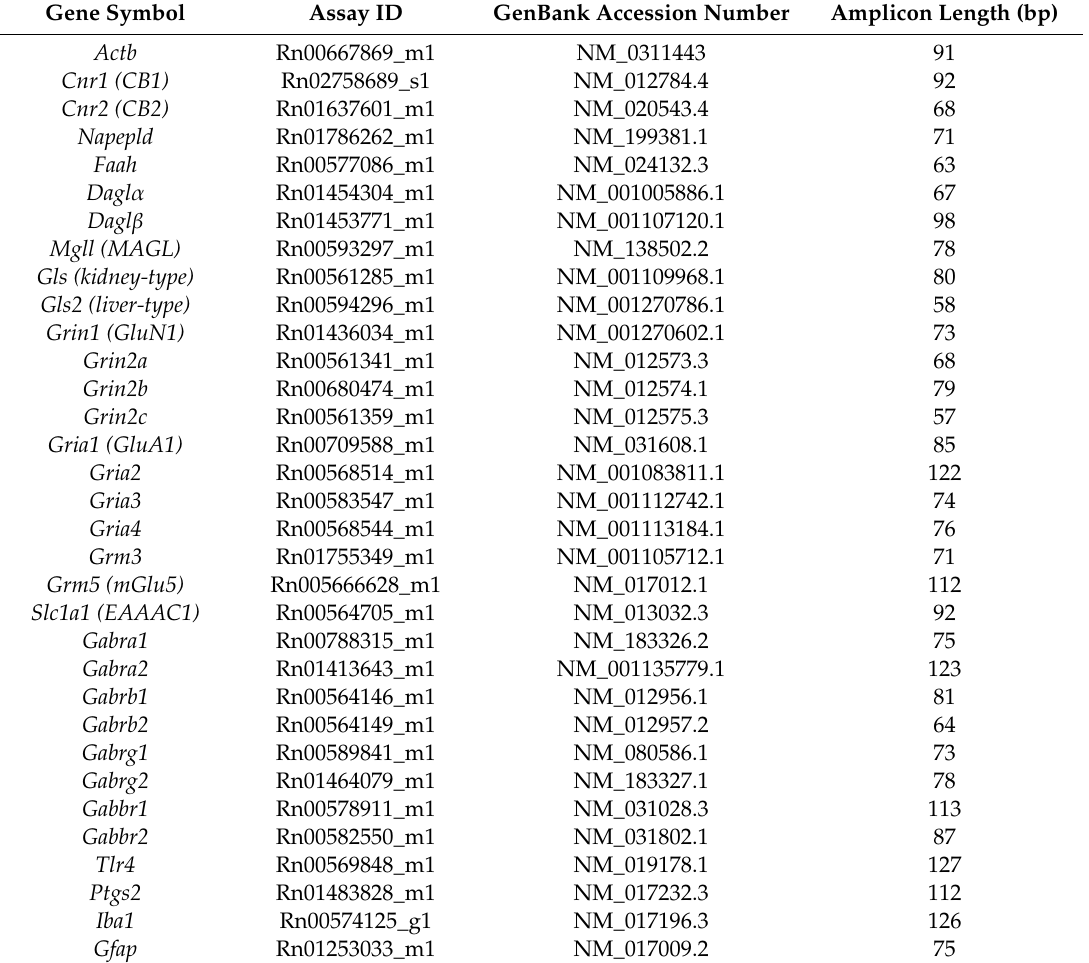
Table 2. Primer references for Taqman ® Gene Expression